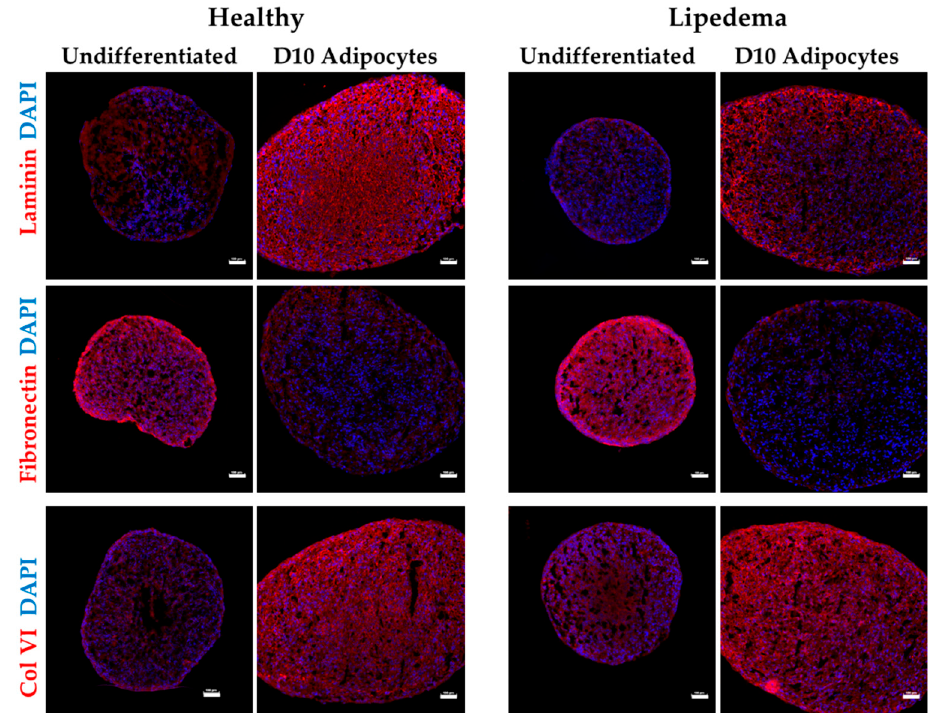
Figure 5. Characterization of ECM components of ASC spheroids. Immunofluorescence staining showing increase in the expression of laminin and Col VI and a decrease in the expression of fibronectin in Day10-differentiated spheroids compare to undifferentiated spheroids. Nuclei were stained with DAPI (blue; scale bar 100 µm).